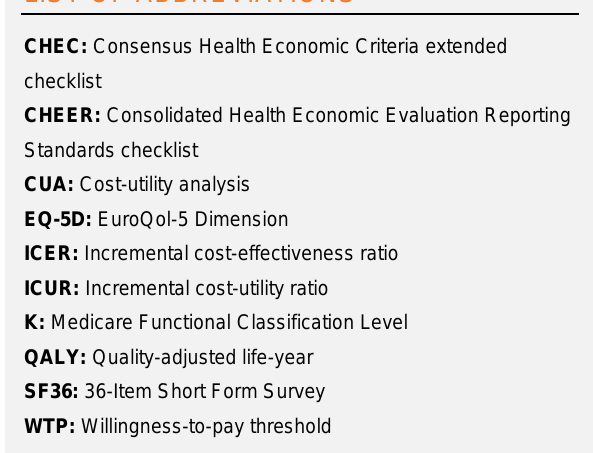
Frossard L. A preliminary cost-utility analysis of the prosthetic care innovations: basic framework. Canadian Prosthetics & Orthotics Journal. 2021; Volume 4, Issue 2, No.10.